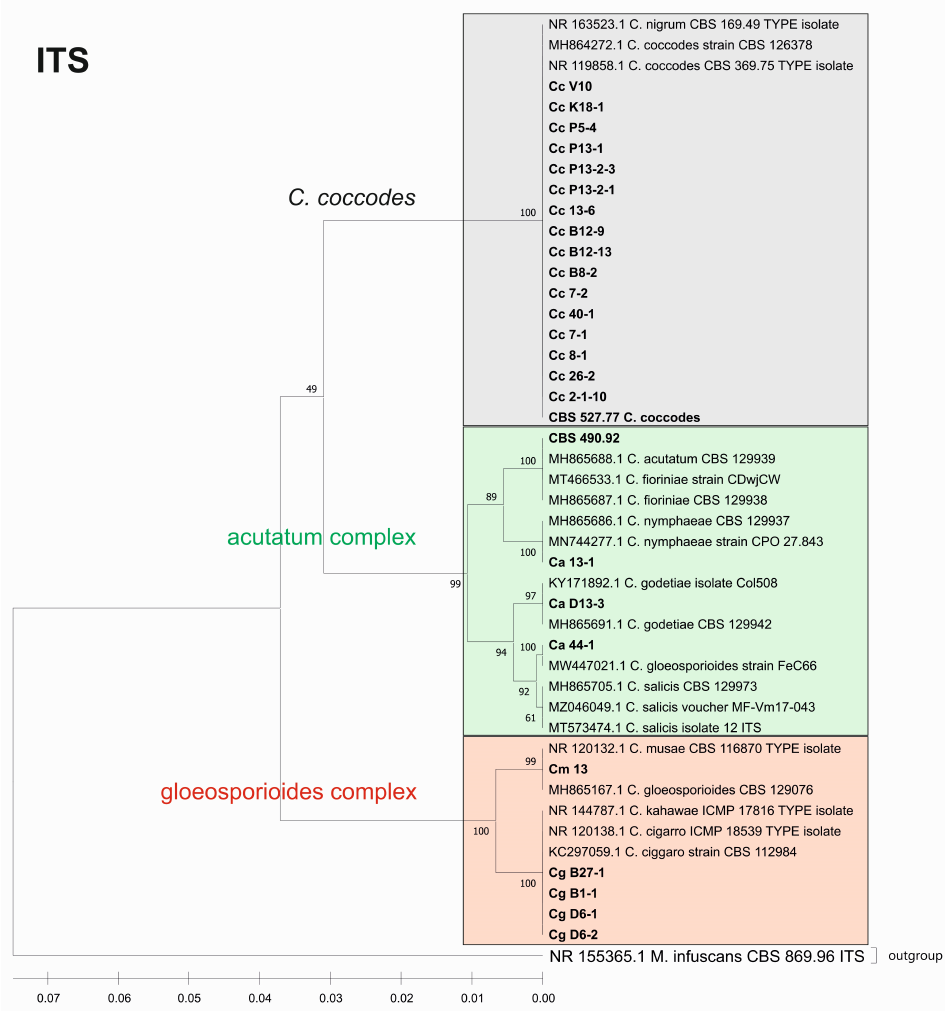
Figure 6. Phylogenetic tree based on the ITS barcode. Genetic diversity and taxonomic assignment of the studied Colletotrichum isolates against accessions in the NCBI database and assessed by the DNA barcode for the ITS locus. The Colletotrichum clades coccodes, gloeosporioides, and acutatum are depicted by grey, red, and green boxes, respectively. The trees were constructed in MEGA11 using the UPGMA clustering method and the Kimura 2-parameter model. The percentage of replicate trees in which the associated taxa clustered together in the bootstrap test (500 replicates) is shown next to the branches. The tree is drawn to scale, with branch lengths in the same units as those of the evolutionary distances used to infer the phylogenetic tree. All ambiguous positions were removed for each sequence pair (pairwise deletion option). Sequences derived from the NCBI are shown with their accession number and organism